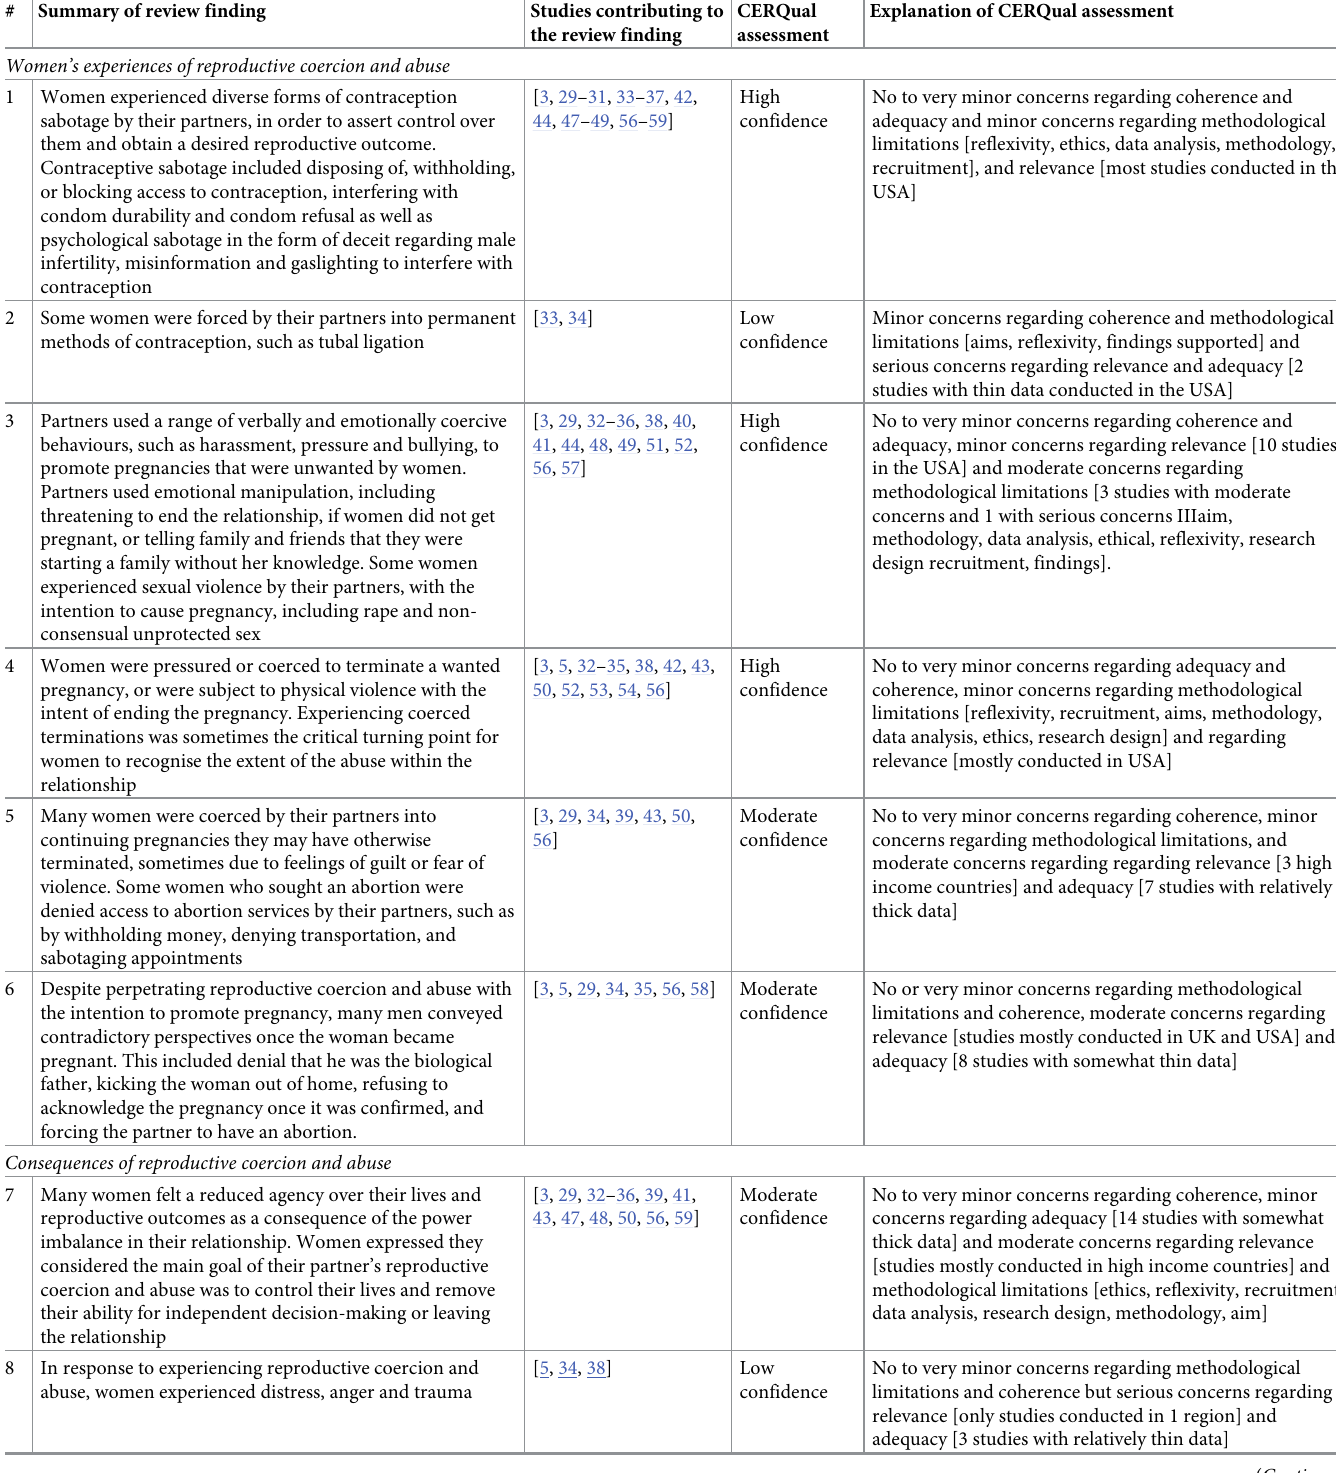
Table 1. Summary of qualitative